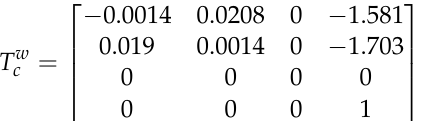
Figure 3. Process Flow of Color Detection using Image Processing